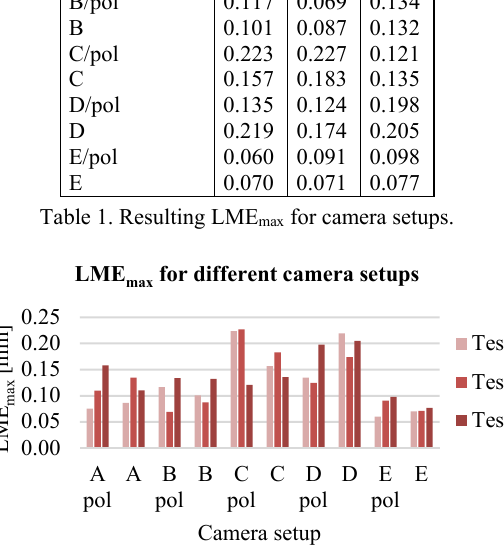
Figure 5. Diagram of LME max for different camera